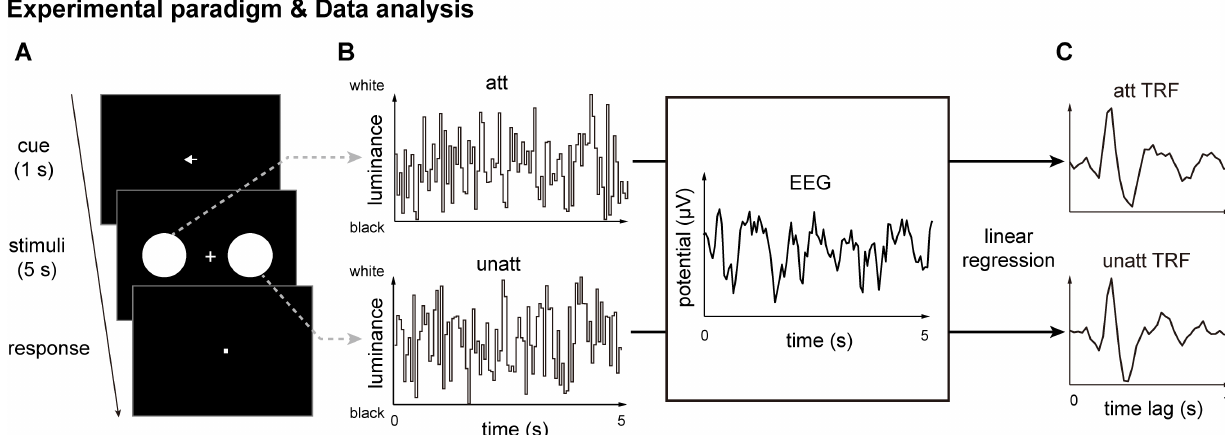
Fig 1. Experimental paradigm for Experiments 1 and 2 and illustration of the temporal response function (TRF) approach. (A) A central arrow cue appearedat the beginningof each trial to indicate which side (left or right) the subject shouldcovertly attend to for subsequent target detection. Two discs were then presented simultaneously in the left and right visual fields for 5 seconds, duringwhich time subjects were instructed to detect the appearance of a target squarewithin the discs by pressing 1 of 2 response keys at the end of each trial. The target occurredat a random time so that subjects had to maintaintheir attention on the discs. Across trials, the contrast of the target square relative to the momentary disc luminancewas adjusted to maintain80% detectionperformance. For 100% cue validity (Experiment 1), the target only appearedin the cued disc; for 75% cue validity (Experiment 2), the target appearedin the cued disc 75% of the time and in the uncued disc 25% of the time. (B) The luminance of the 2 discs was independently and randomly modulated throughoutthe trial, resulting in 2 independent5 s randomtemporal sequences(example sequencesare shown; top: attendedvisual stimulus luminancesequence, bottom: unattendedvisual stimulus luminancesequence).At the same time, electroencephalography (EEG) responses were recorded. (C) The TRF approach was used to calculatethe impulse brain responsefor the attended(top, att) and unattended (bottom, unatt) visual sequences. TRF characterizes the brain responseto a unit increasein luminancein a stimulus sequence,with the time axis representing the latency after each transient unit. Note that the att TRF and unatt TRF were derived from the same EEG responses but were separated based on the corresponding stimulus luminance sequence(see panel B).